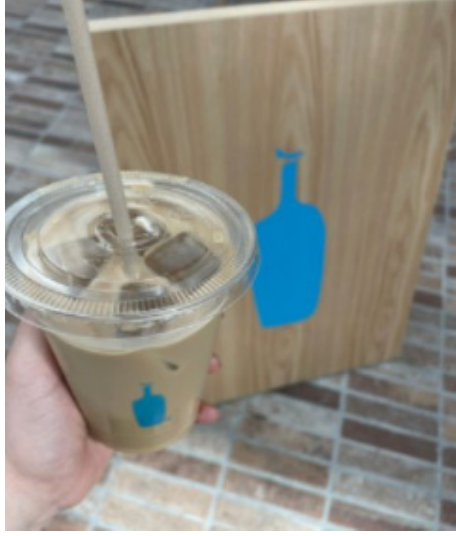
Figure 30. Blue Bottle straw made of bamboo fiber.